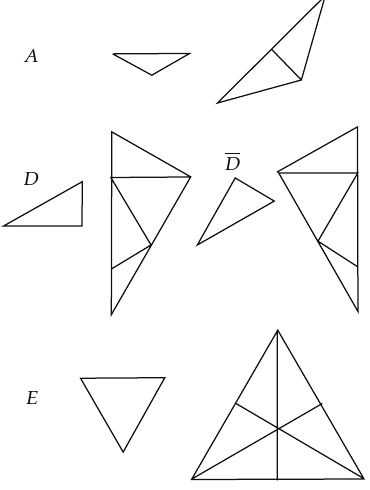
Figure 7: Inflation rules for T